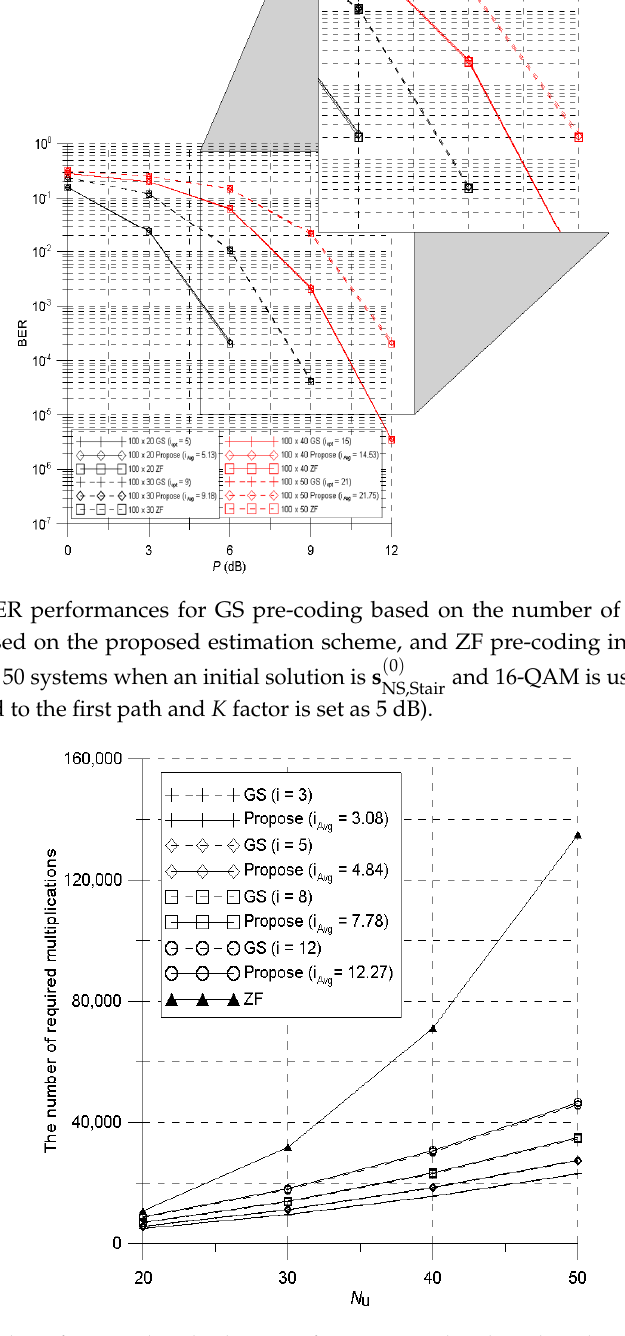
Figure 12. The number of required multiplications for GS pre-coding based on the proposed estimation scheme when an initial solution is s NS,Stair